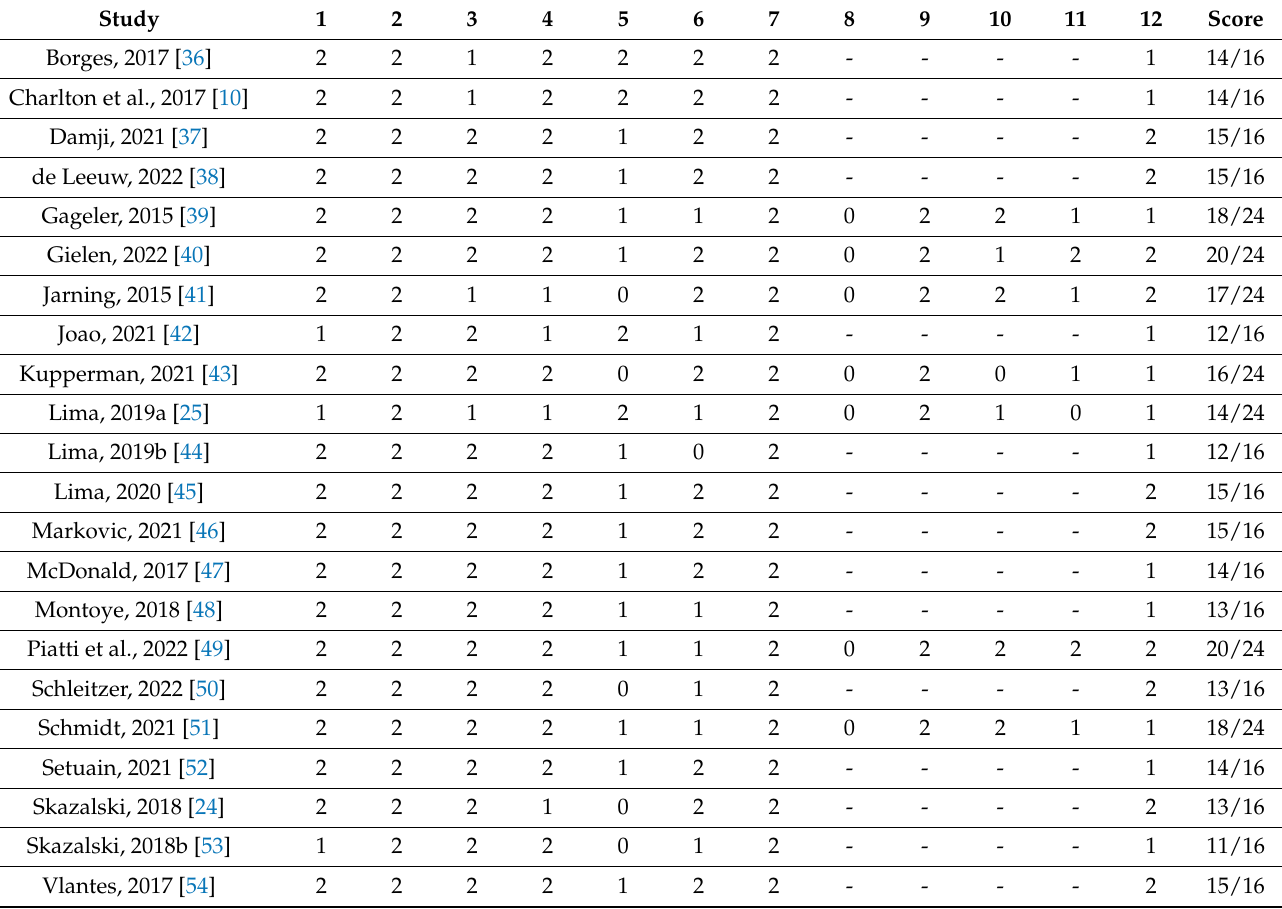
Table 2. Methodological risk of bias assessment using MINORS